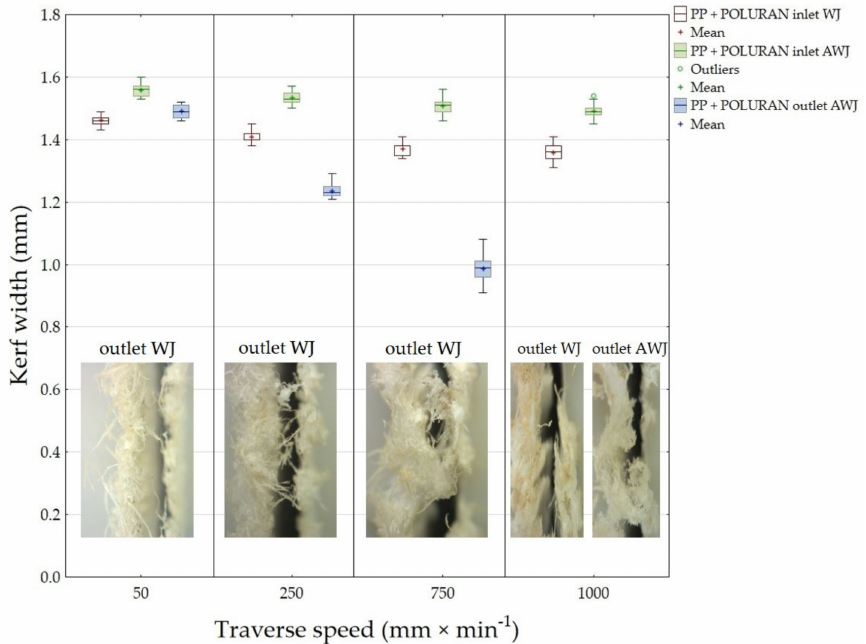
Figure 13. Dependence of the width of the cutting gap on the traverse speed of the cutting head and the type of water jet for PP + POLURAN.